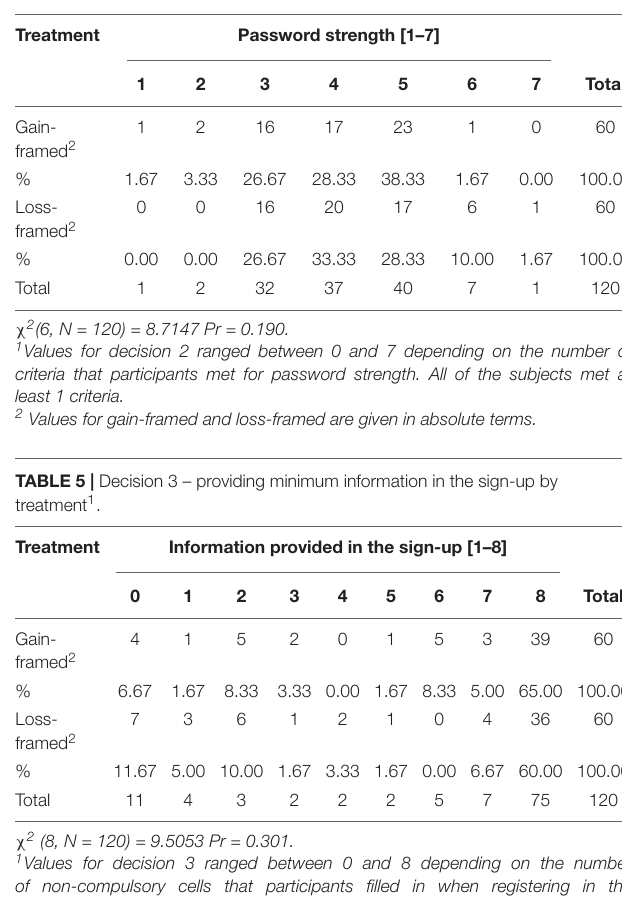
TABLE 7 | Decision 5 – logging out by treatment 1 .